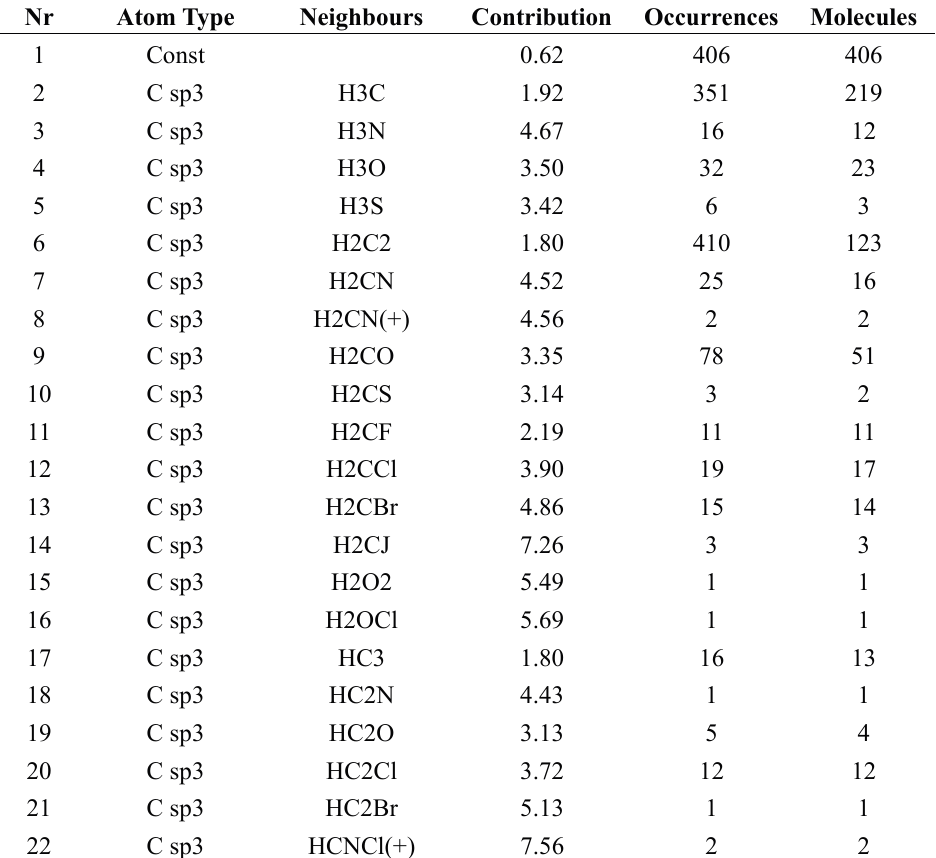
Table 14. Atom group Contributions for Polarizability